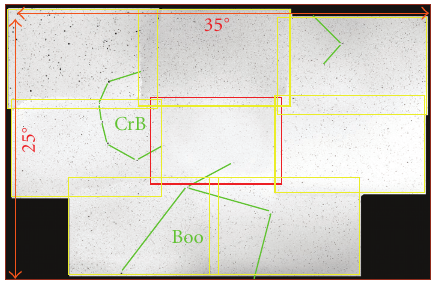
Figure 4: The AROMA-W FOV. This is a combined image of 20 frames of W band exposed for 30s. The mosaic image shows the data taken by all eight cameras, in which the red rectangle displays the FOV of 5D and the yellow FOVs of 350Ds.